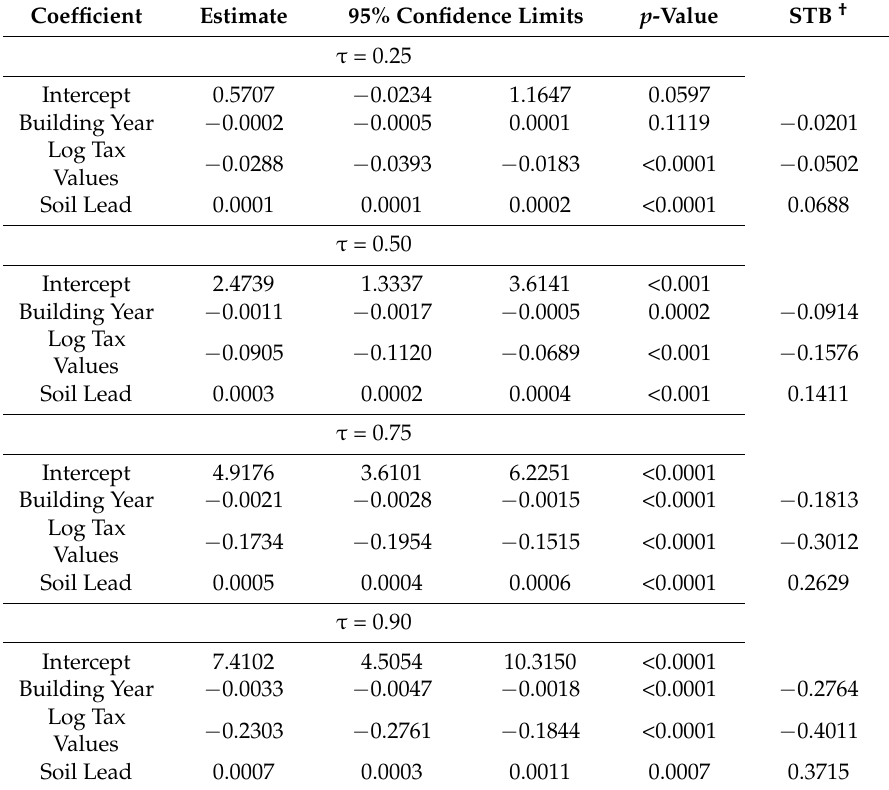
Table 3. Coefficient estimates of global quantile regression models for τ = 25, 50, 75 and 90.